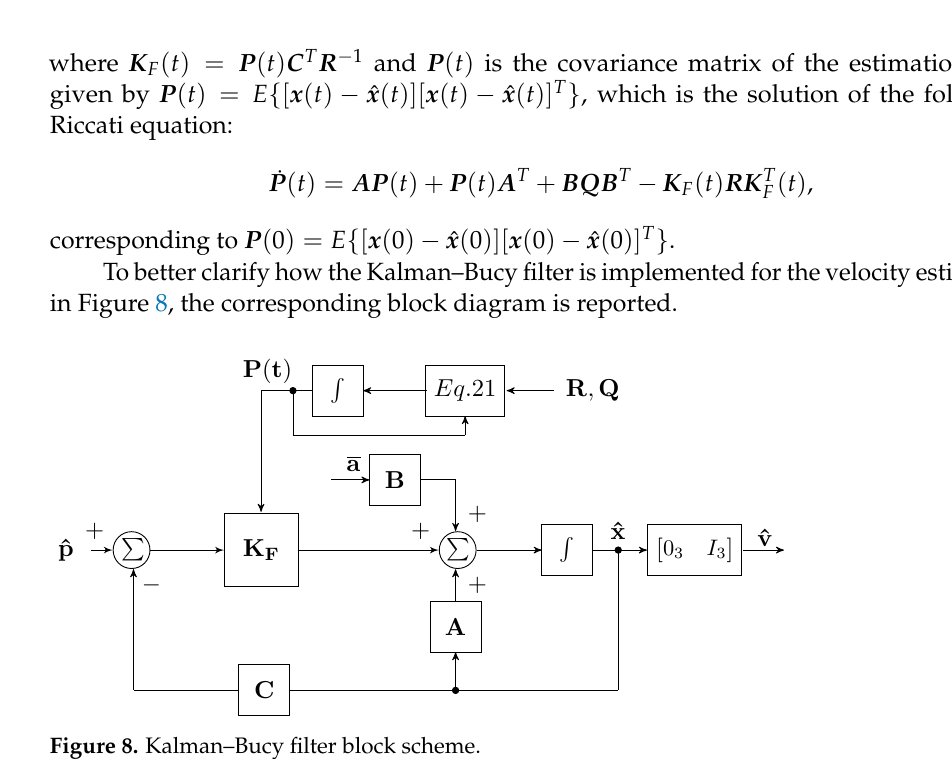
Figure 8. Kalman–Bucy filter block